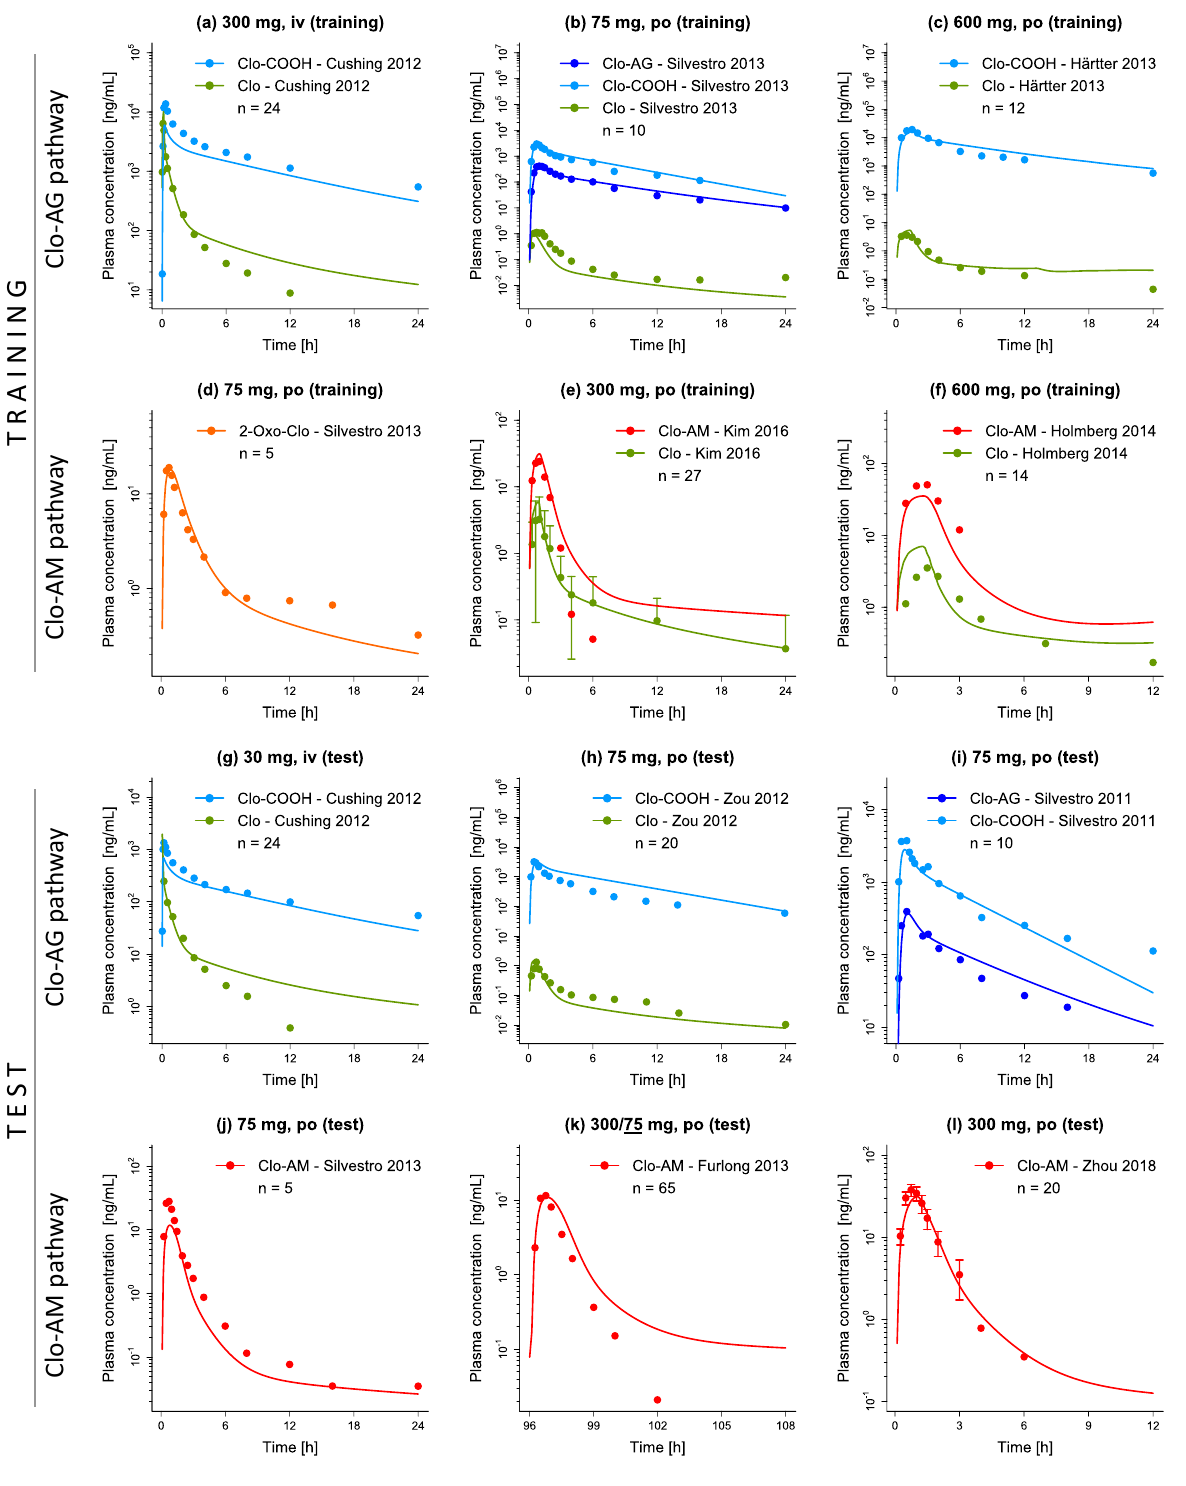
Figure 2. Representative plots of predicted plasma concentration-time profiles of clopidogrel and its metabolites. Split up according to ( a – f ) training and ( g – l ) test datasets, solid lines represent the model predictions, while corresponding observed data are shown as symbols ( ± standard deviation, if available) [23,42,44,46,47,54,59,62,72]. Detailed information on all profiles and clinical studies, can